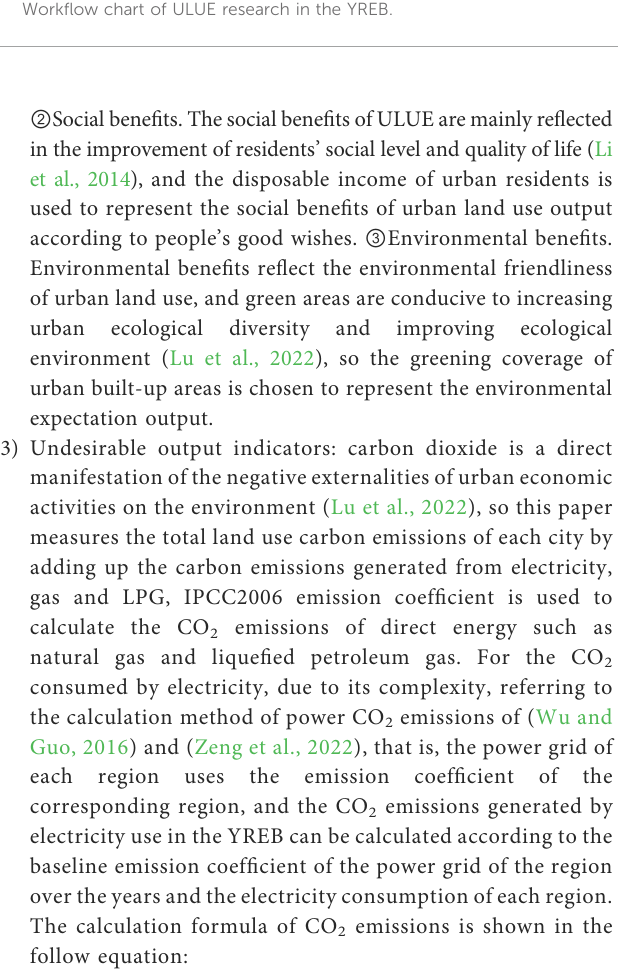
FIGURE 2 Work fl ow chart of ULUE research in the